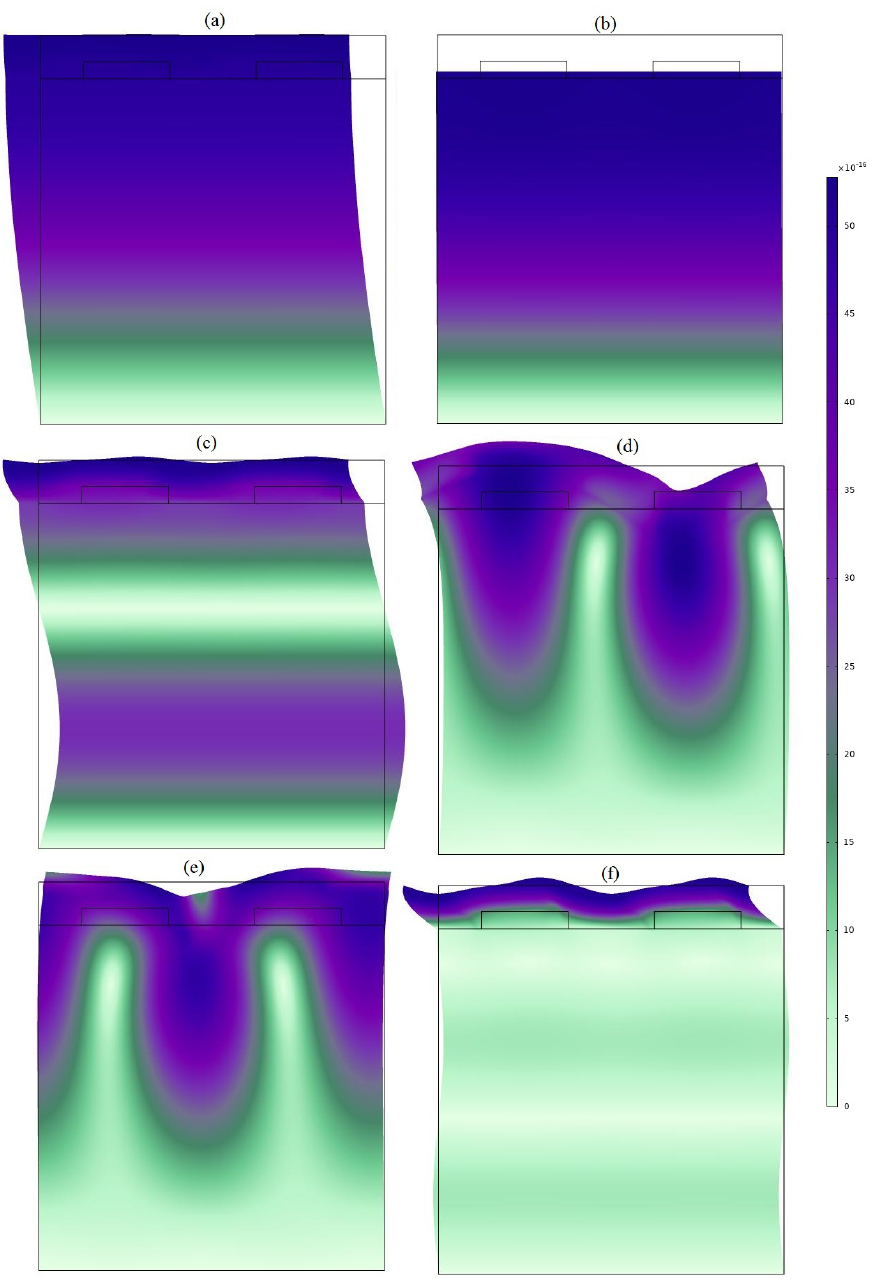
Figure 4. First six modes of SAW problem with cooling: ( a ) mode 1, ( b ) mode 2, ( c ) mode 3, ( d ) mode 4, ( e ) mode 5, ( f ) mode